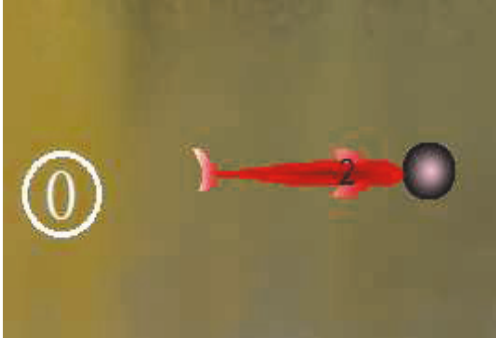
Figure 3: An illustration of the classic action decision strategy.